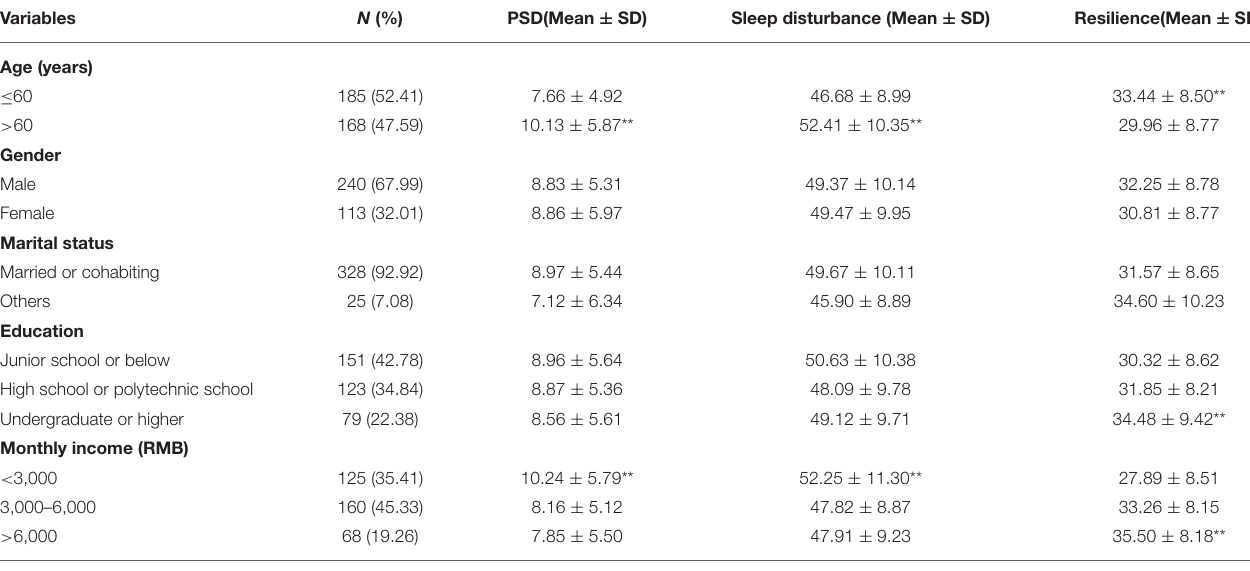
TABLE 1 | Demographic characteristics and distributions of PSD, sleep disturbance, and resilience among stroke patients.